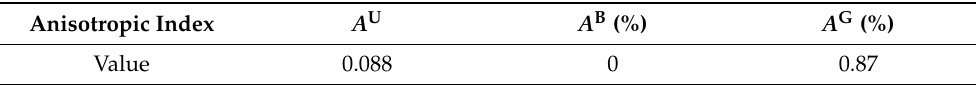
Table 4. The calculated anisotropic indices of the Ag 9 In 4